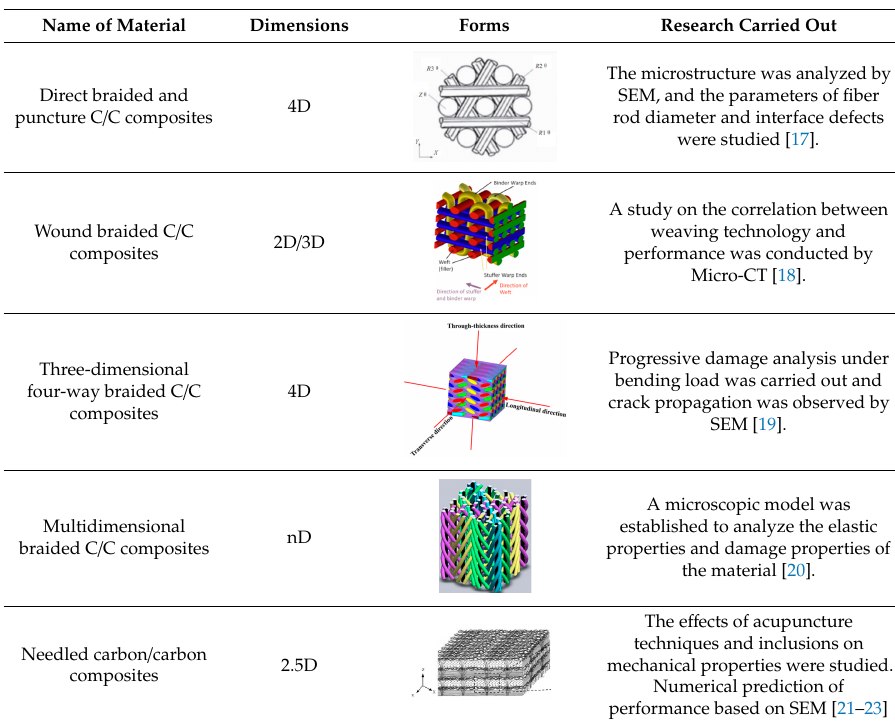
Table 1. Research progress on microstructure characteristics of C/C composites.